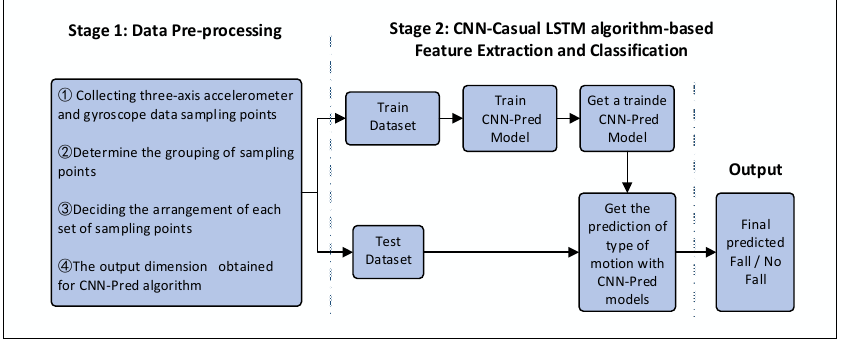
Figure 1. The proposed approach for fall detection by using a convolutional neural network.